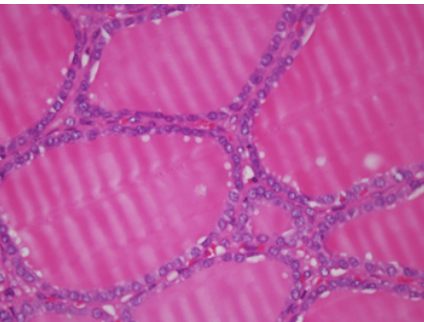
Figure 2: Follicular structures lined by tumor cells that include papillary carcinoma nuclear